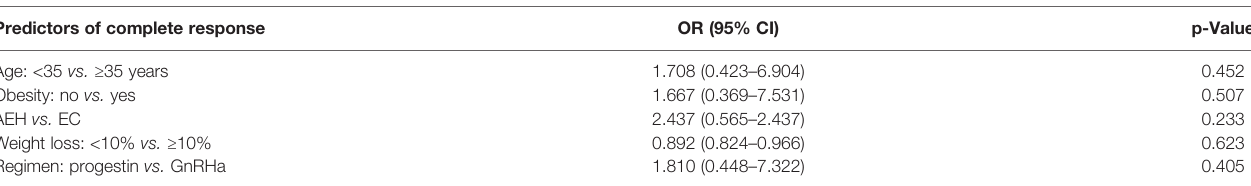
TABLE 2 | Predictors of complete